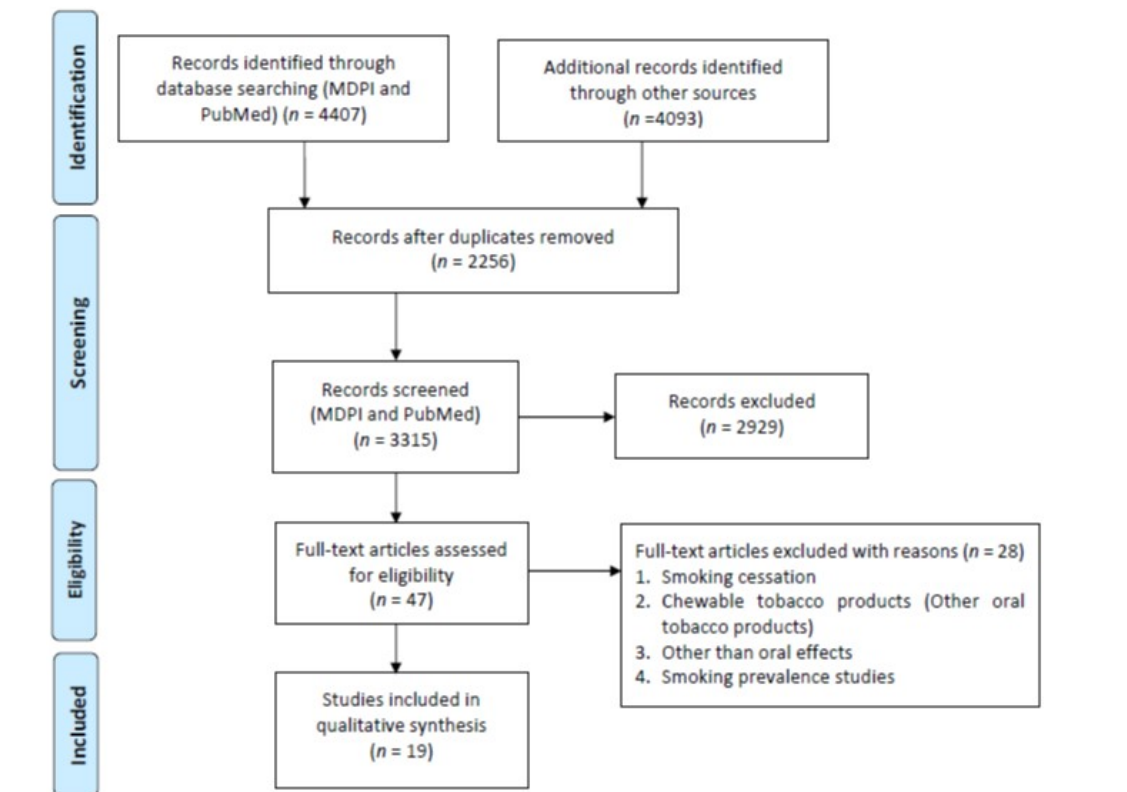
Figure 2. Flowchart of articles retrieved from different Web sources. Int. J. Environ. Res. Public Health 2021 , 18 , x